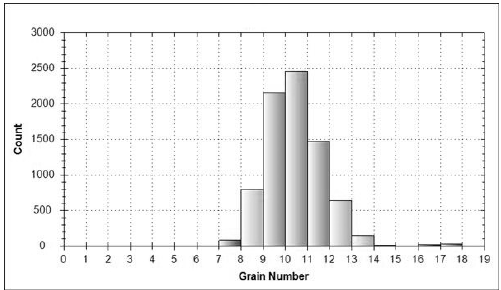
Figure 10. Grain size distribution for the austenitizing temperature of 920°C.